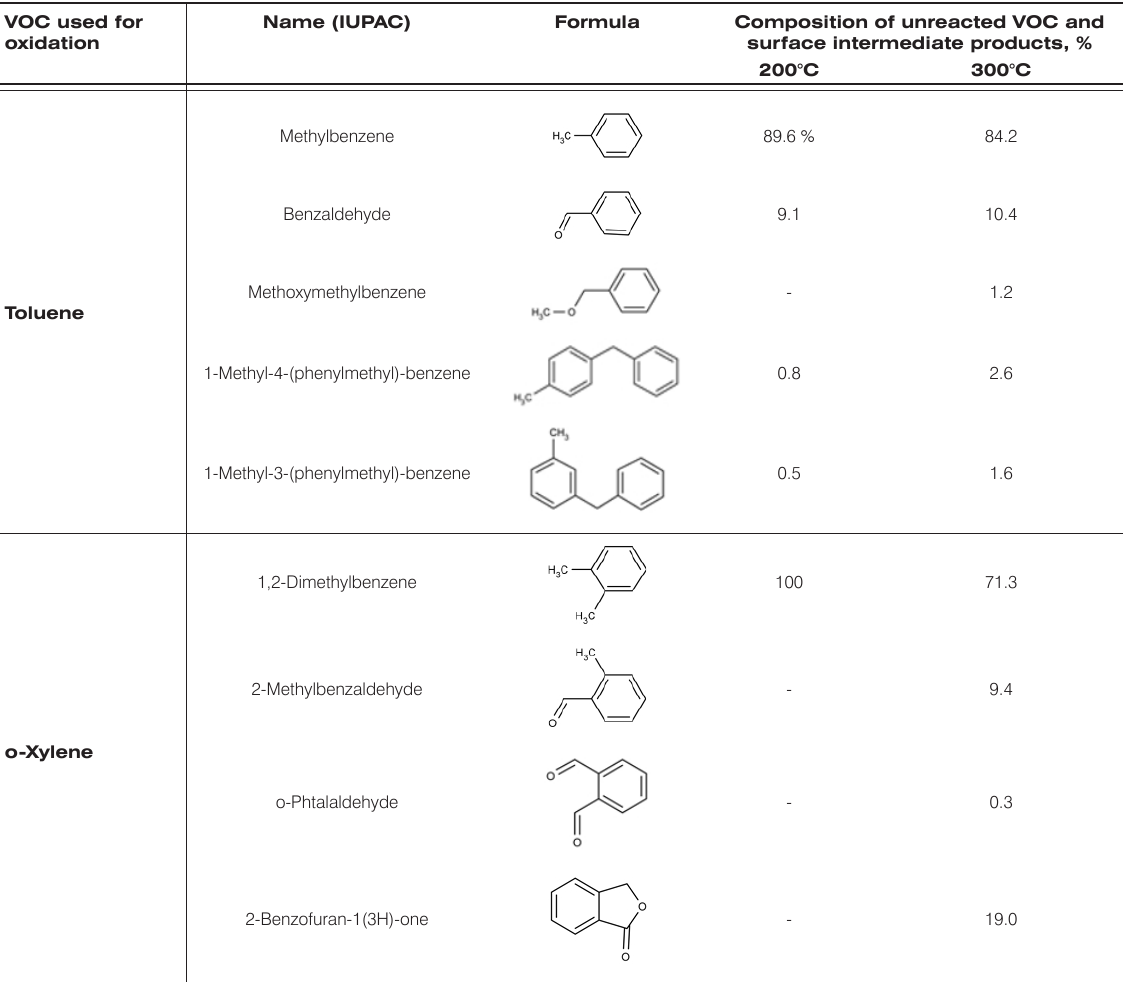
/NaX at different temperatures. 2